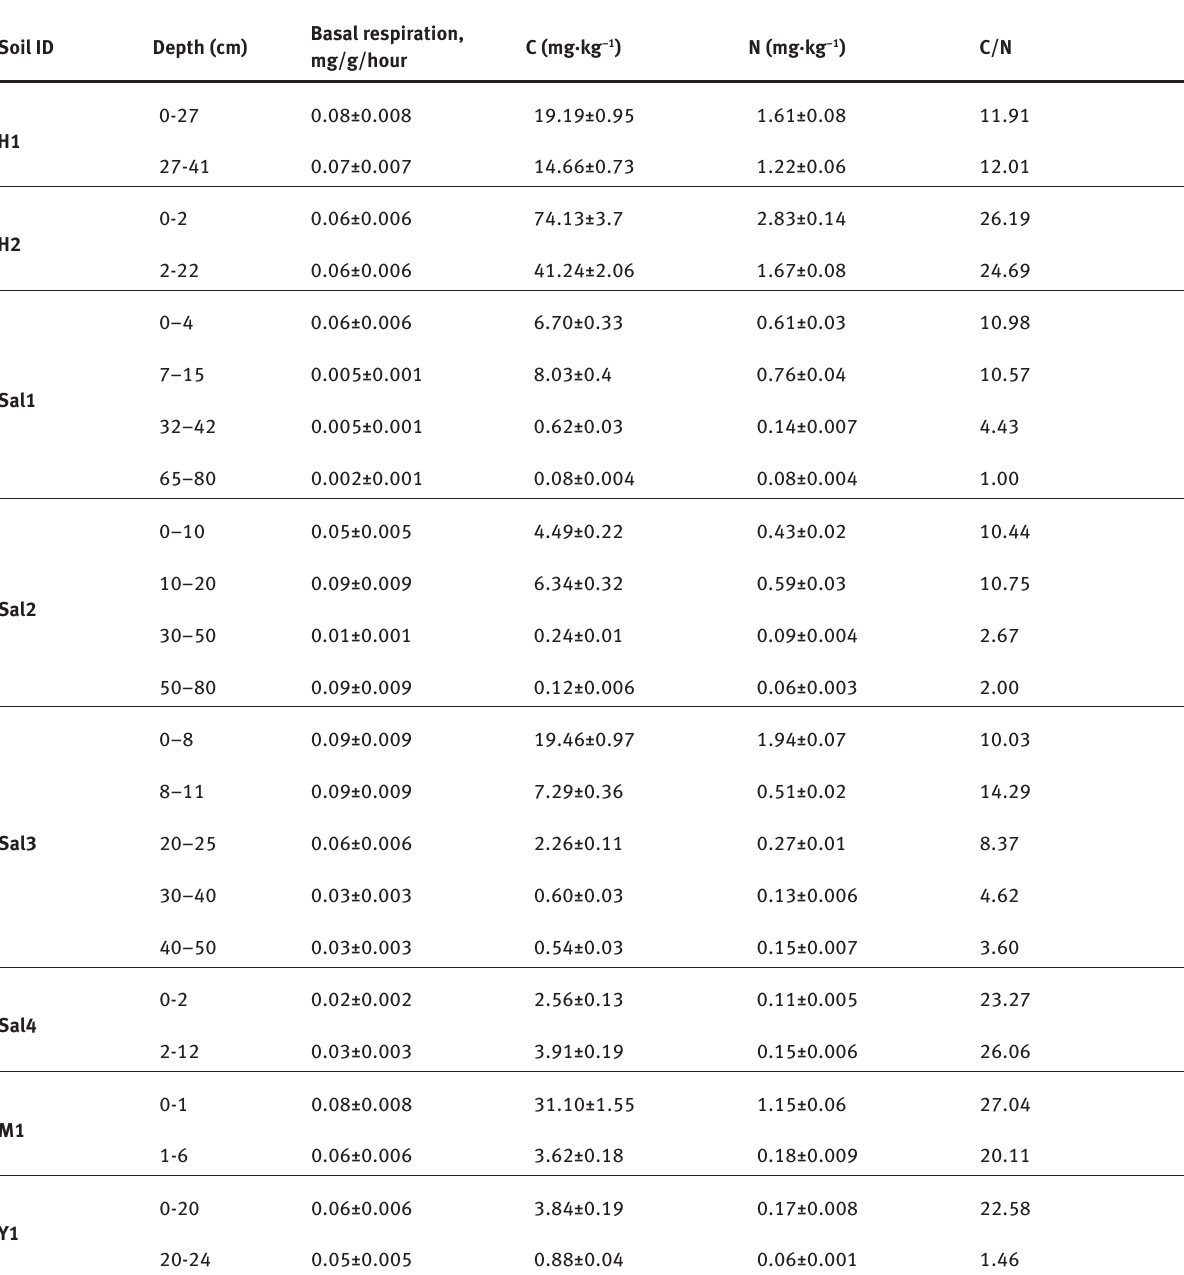
Table 3: The carbon and nitrogen content of the Salekhard soils. Mean±SD. n=3